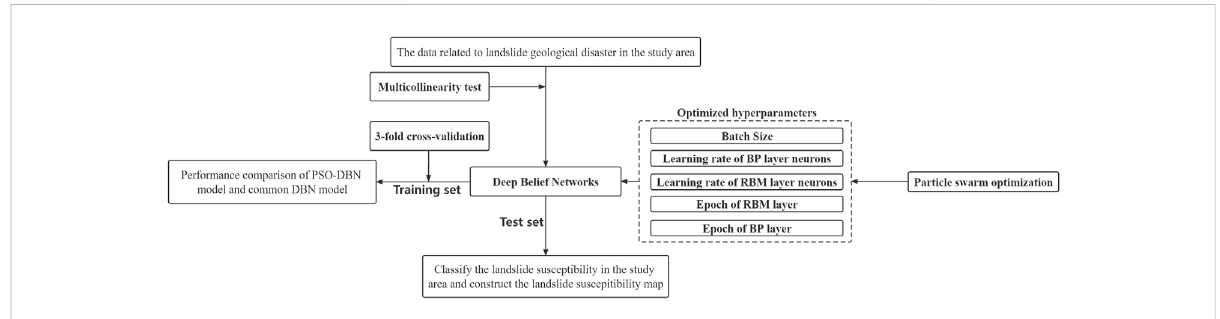
FIGURE 2 Research framework